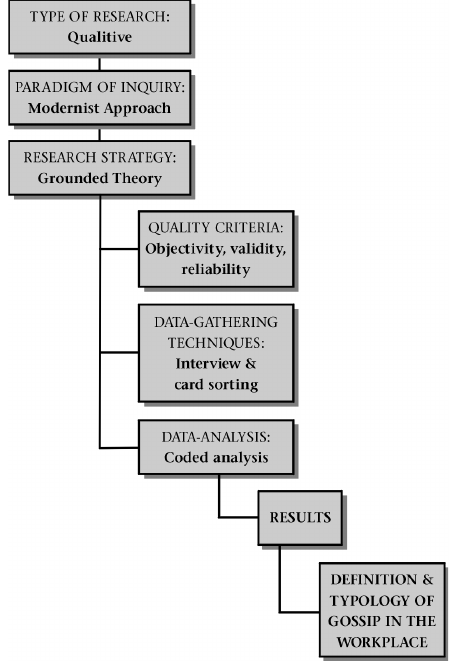
Figure 2: Research